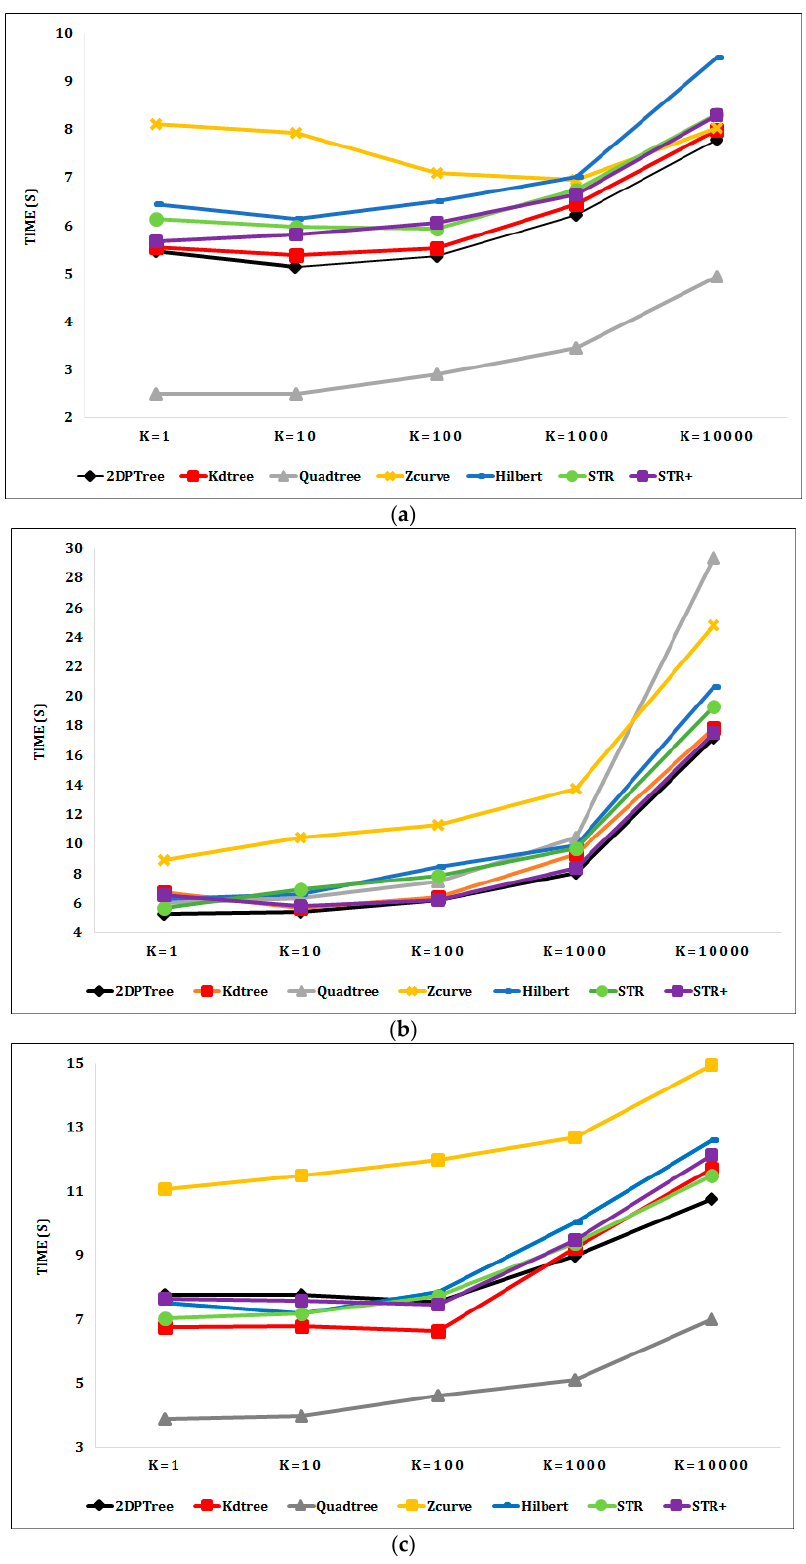
Figure 10. kNN query execution times for indexed real datasets: ( a ) kNN on the Sports dataset with k equal to 1, 10, 100, 1000, and 10,000 points; ( b ) kNN on the Cities dataset with k equal to 1, 10, 100, 1000, and 10,000 points; ( c ) kNN on the Buildings dataset with k equal to 1, 10, 100, 1000, and 10,000 points.